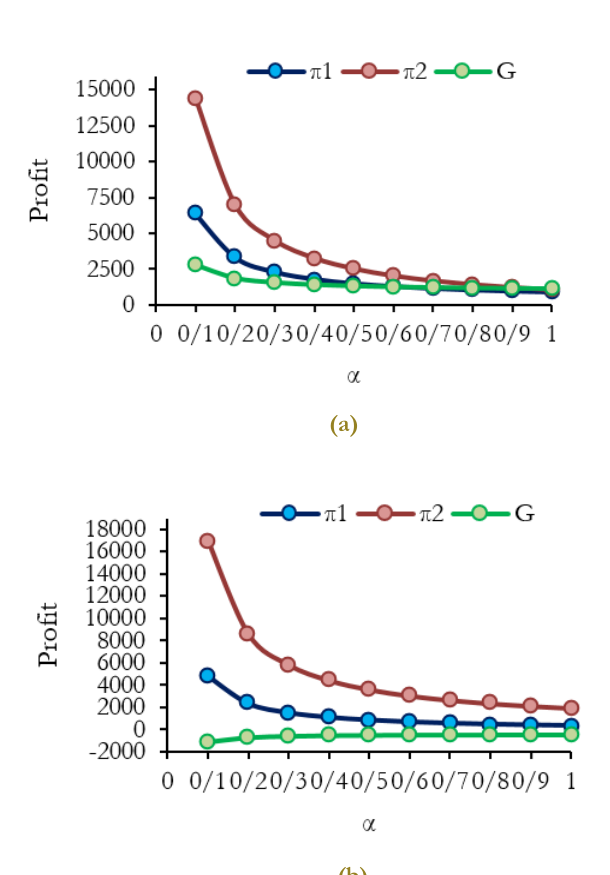
Fig. 7. The impact of α on the profits of dental centers and the government's utility: (a). λ = 0; (b). λ =